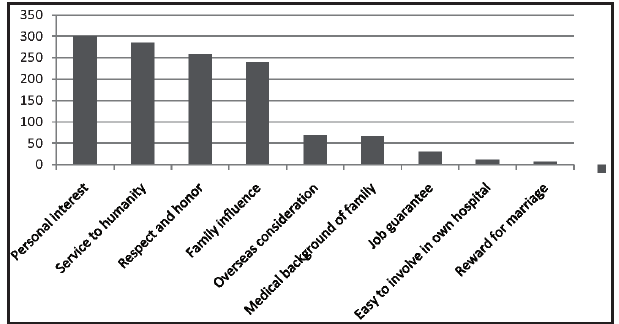
Diagram 1: Factors for choosing medicine as a profession Fig 1 : Factors for choosing medicine as a profession (N-300)